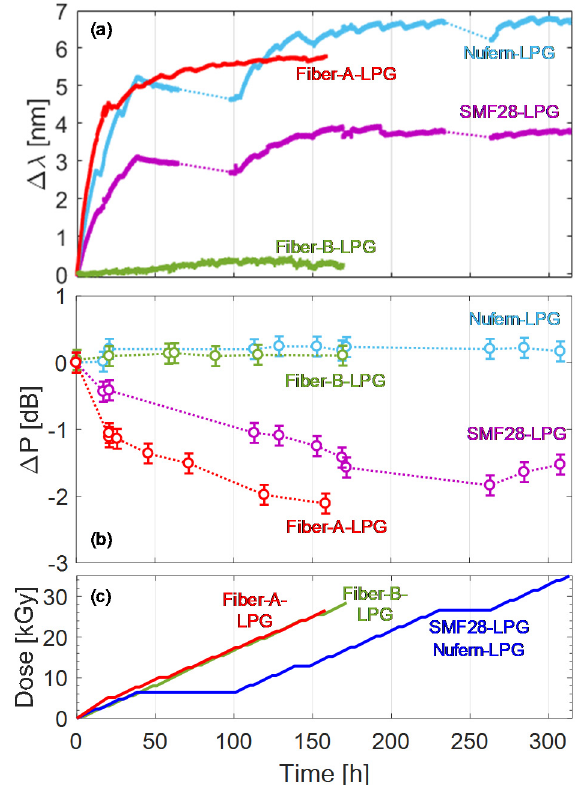
Figure 4. Gamma irradiation of arc-induced LPGs: ( a ) resonance wavelength shift; ( b ) transmitted power variation; ( c ) irradiation profiles. © 2019 IEEE. Reprinted with permission from [79].